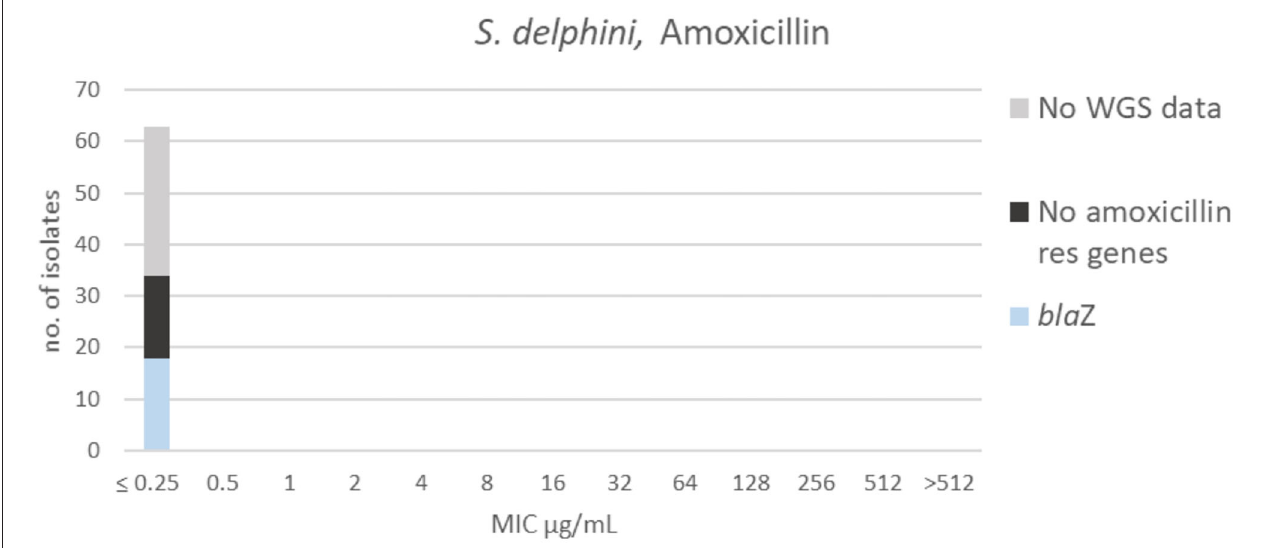
FIGURE 7 | MIC distribution of Staphylococcus delphini ( n = 63) against amoxicillin in the test range of 0.25–512 µ g/mL. Colors indicate if the isolates have been sequenced and whether they habor known relevant resistance genes. WGS, whole-genome sequencing; res, resistance.